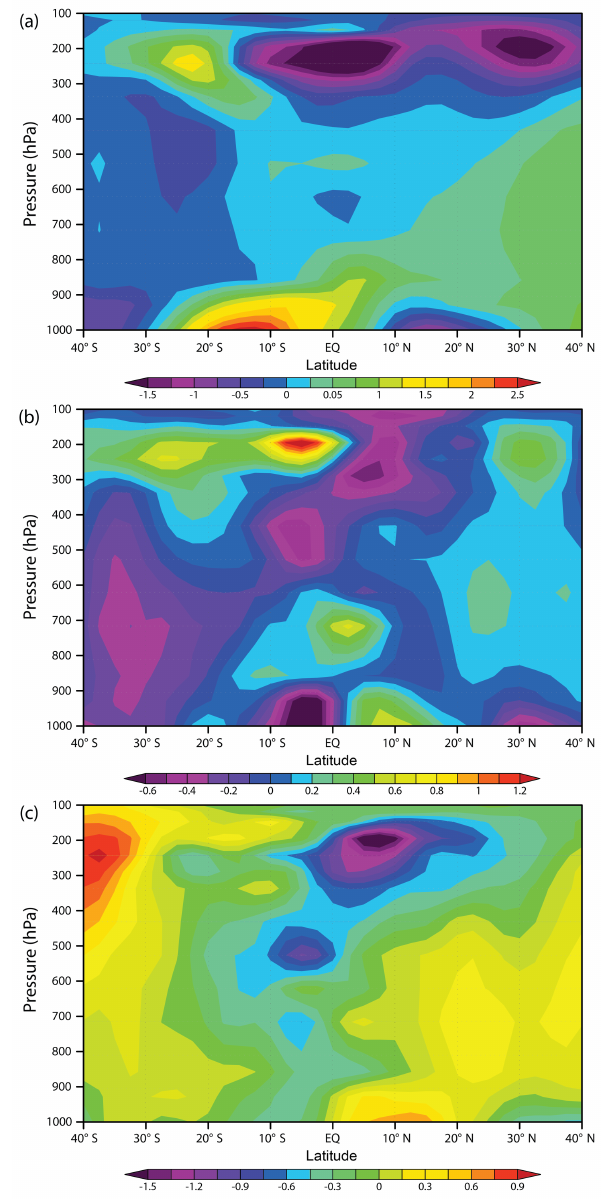
Figure 6. Latitude–height cross section of June to August 120– 240 ◦ E average (a) meridional wind v (ms − 1 ) for 1979–2016, (b) meridional wind v difference of 2016 minus 1979–2016, and (c) meridional wind v difference of 2016 minus